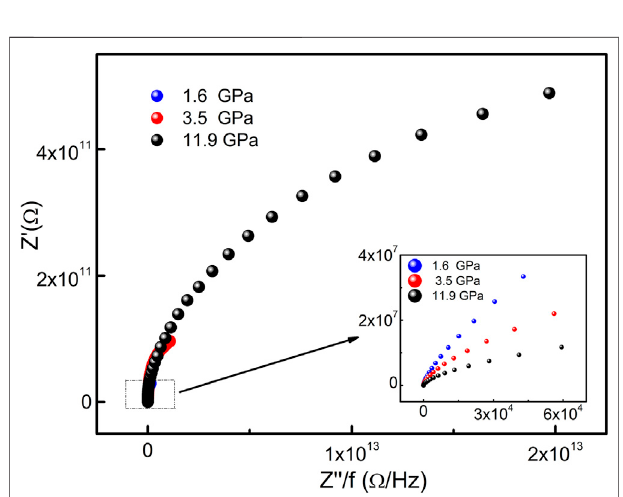
FIGURE 4 | Z ′ - Z ″ / f plots of phenanthrene at different pressures. Inset: the enlargement of the left arc.